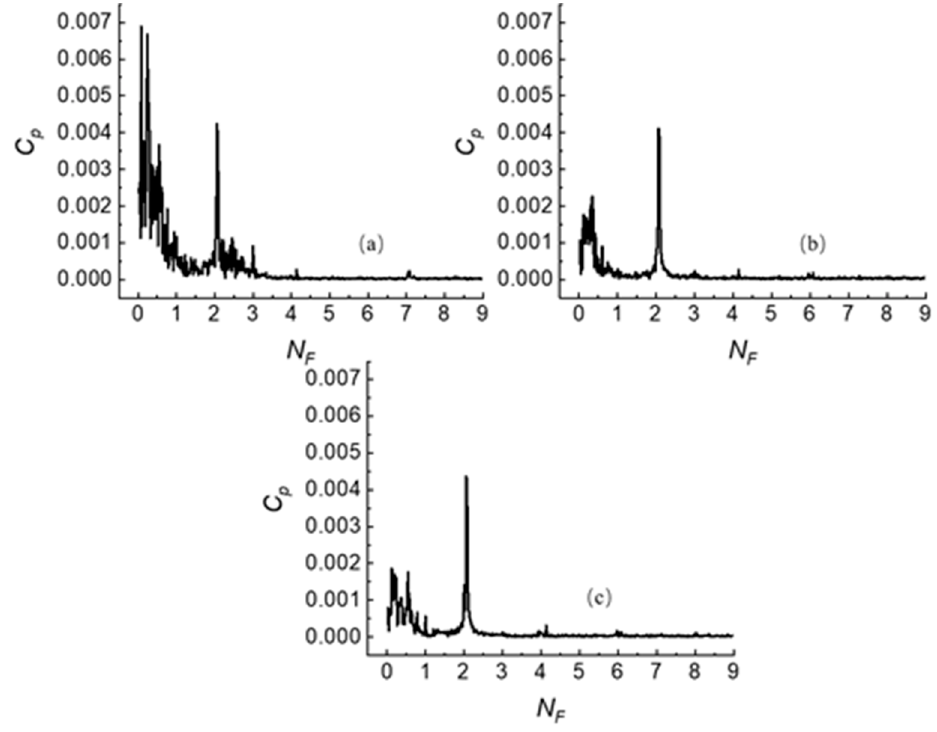
Figure 12. Frequency domains of the inlet pressure fluctuation under different flow rates ( a ) 0 . 6 Q d , ( b ) 1.0 Q d , ( c ) 1.1 Q d